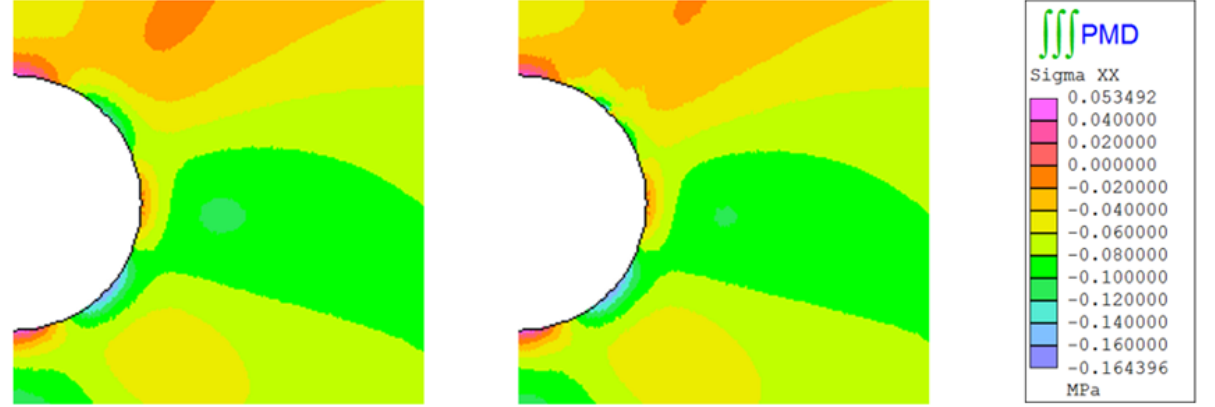
Figure 4. Rock behaviour in the stress - σ xx curve without rock bolts (left) and with rock bolts (right)